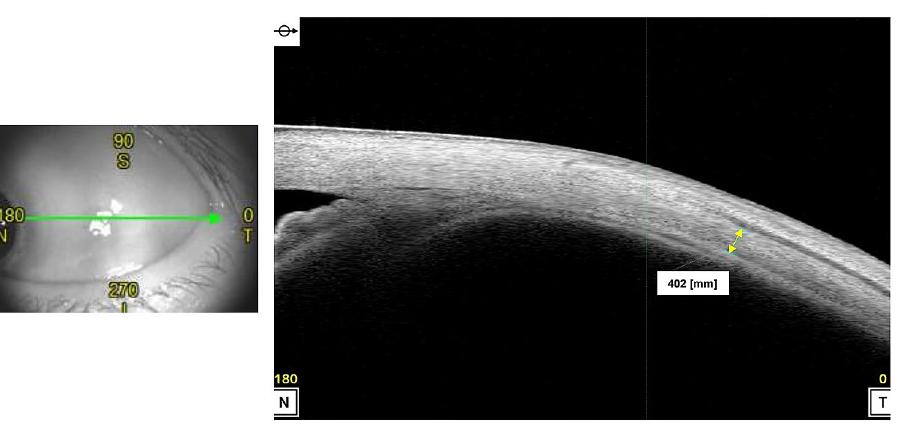
Figure 5. Method of obtaining image of temporal sclera and measuring scleral thickness using anterior segment optical coherence